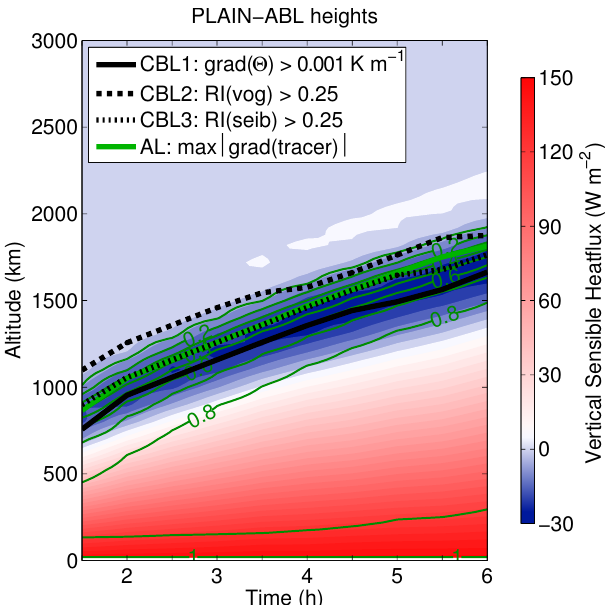
Figure 2. Temporal evolution of mean boundary layer heights of the PLAIN simulation. Shown are three different temperature-based CBL heights and the AL height (see Sect. 4). Thin green contour lines display horizontally averaged normalized tracer mixing ratios (0.1 increment) for a horizontally homogeneous tracer source at the surface. Color contours represent total vertical sensible heat flux profiles of the PLAIN simulation. Due to technical reasons (time averaging), values are only shown for simulation times after 1 .